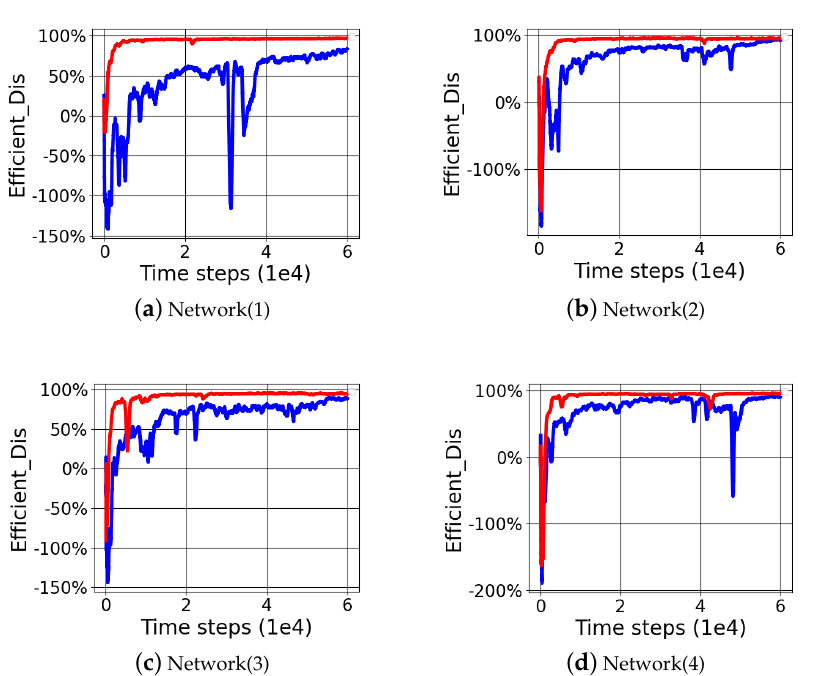
Figure 7. Under the reward function(1), the efficient distances between RTD3(red) and TD3(blue) for four times of randomly initialized network node parameters under the same initial network node conditions as shown above in ( a – d